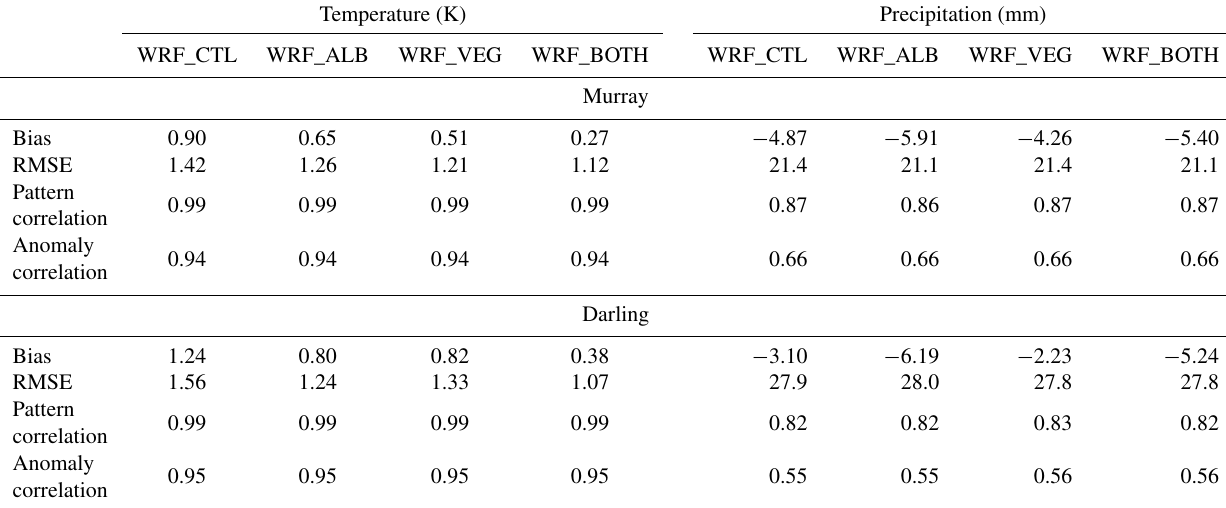
Table 1. Summary evaluation statistics for monthly temperature and precipitation fields simulated by each experiment compared to AWAP